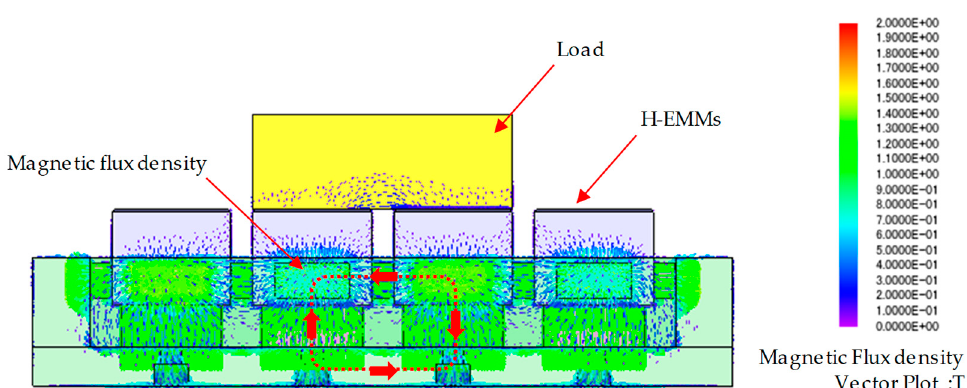
Figure 8. Magnetic flux density of the H-EMMs in detachment mode.